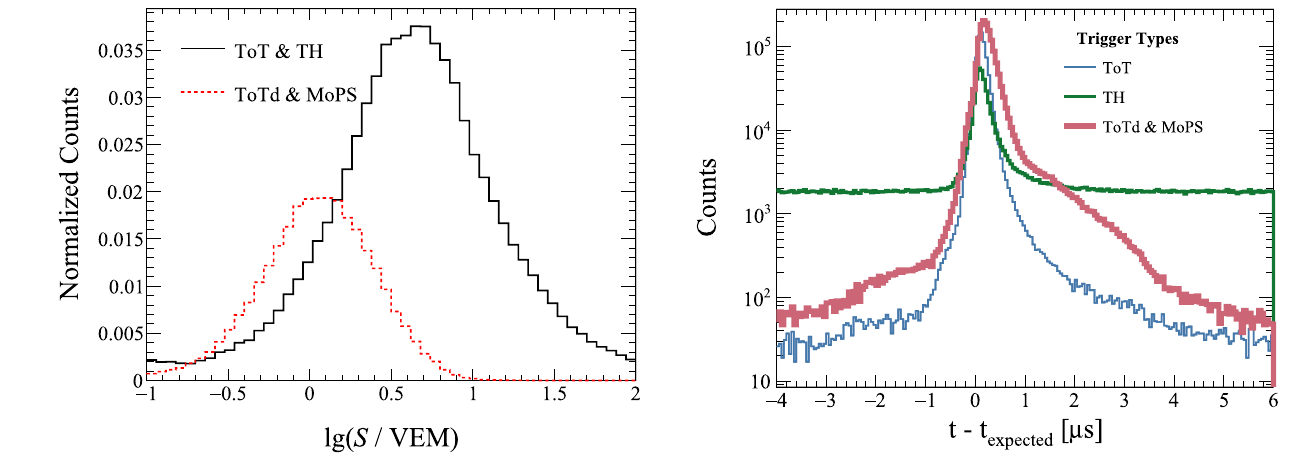
Fig. 2 Distribution of the signal sizes at individual stations which pass the TH and ToT triggers (solid black) and signals which pass only the ToTd and/or MoPS triggers (dashed red)